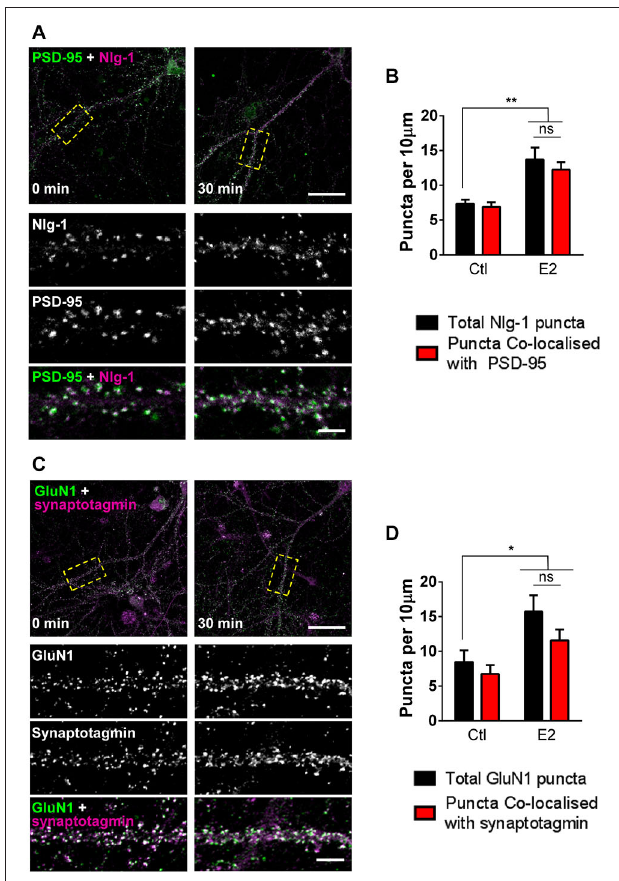
FIGURE 2 | E2 rapidly increases presence of proteins involved in synaptogenesis at synapses. (A) Representative confocal images of primary cortical neurons (DIV 25) fixed following treatment with E2 or vehicle (30 min). Neurons were immunostaining for Nlg-1 and PSD-95. Insets are of magnified regions denoted by yellow dashed boxes in low magnification images (top). (B) Quantification of (A) . Nlg-1 puncta density increases following E2 treatment; a concurrent increase in Nlg-1/PSD-95 co-localized puncta is also observed ( ∗∗ p < 0.01, n = 9–10 cells). (C) Confocal images of DIV 25 primary cortical neurons treated with or without E2 for 30 min and co-stained for NMDA receptor subunit GluN1 and pre-synaptic protein synaptotagmin. Yellow dashed boxes in low magnification images (top) indicate region of dendrite magnified in insets. (D) Quantification of (C) . After 30 min of treatment with E2, overall GluN1 puncta density increases; measurements of GluN1/synaptotagmin co-localized puncta also reveal an increase in density ( ∗ p < 0.05; n = 10 cells per condition). In all images, overlap is indicated by white. Scale bar = 5 µ